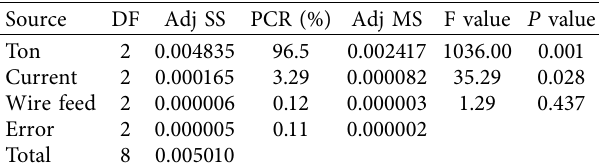
a . (a) MRR. (b) R a . Table 4: ANOVA table for